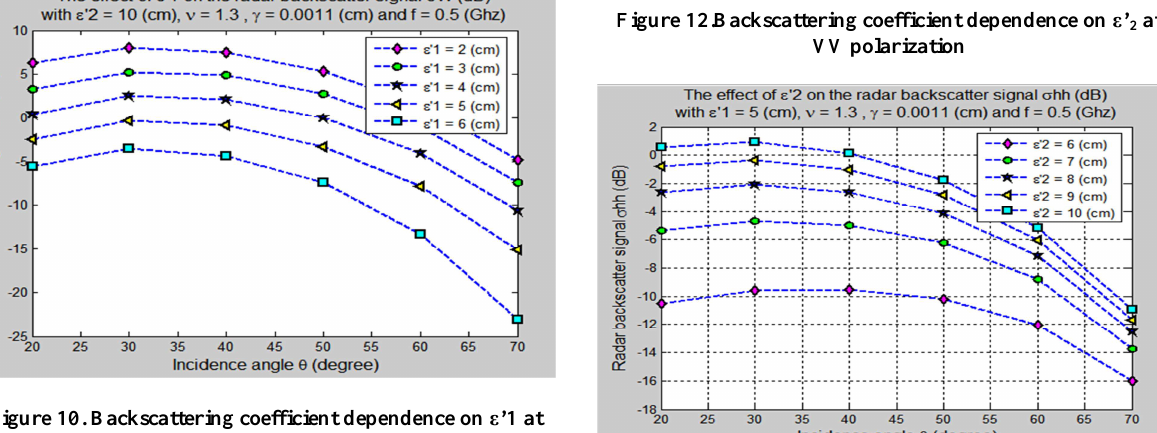
Figure 10. Backscattering coefficient dependence on ε ’1 at